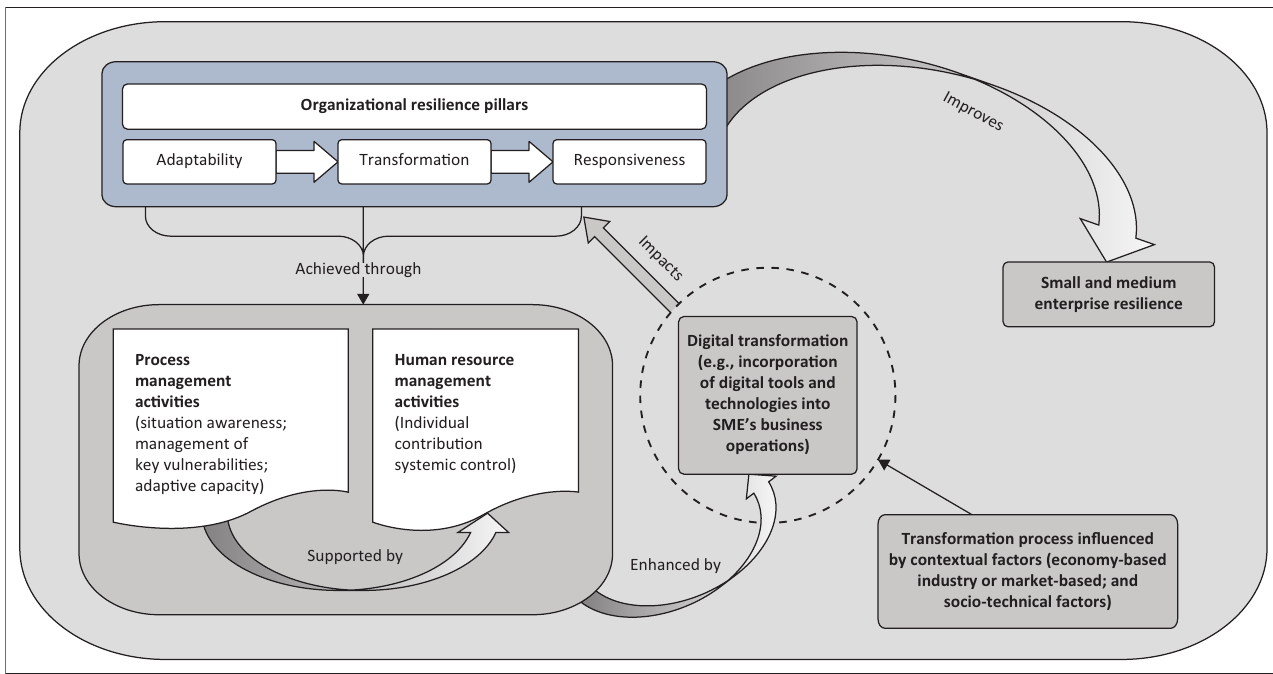
FIGURE 3: Conceptual framework for small and medium enterprises’ digital transformation considerations.